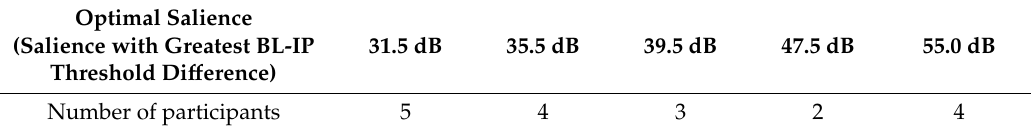
Table 1. The number of participants showing peak IP benefit relative to BL at each auditory salience level.